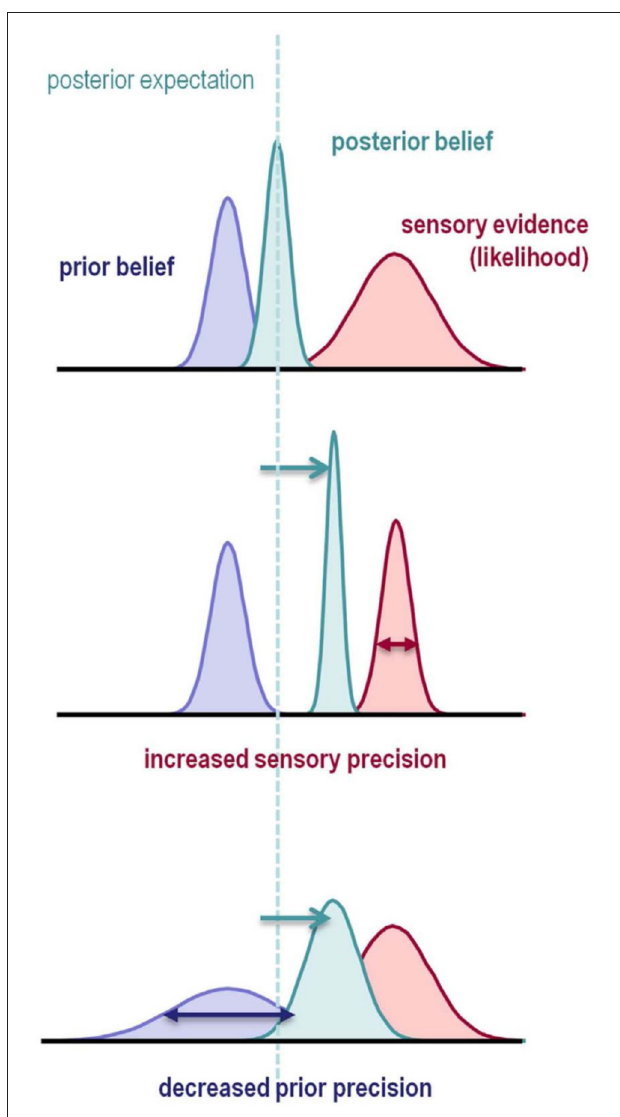
FIGURE 2 | Illustration of Bayesian Inference. The prior belief (blue) about a state is updated by sensory evidence (red) represented by the likelihood function. The updated belief is the posterior belief (turquoise), which will serve as the prior belief in the next updating step. Each row illustrates how the shape of the prior distribution and the likelihood influence the inference process. Both an increase in likelihood precision (inverse variance), and a decrease in prior precision result in a posterior belief which is more biased toward the sensory evidence. This is illustrated by a deviation of the posterior toward the sensory evidence and away from the prior belief (dashed line and arrows). In the Bayesian predictive coding framework (Friston and Kiebel, 2009; Rao and Ballard, 1999), inference naturally minimizes the prediction error, defined as the difference between expected and observed outcomes. Figure reprinted from Adams et al.